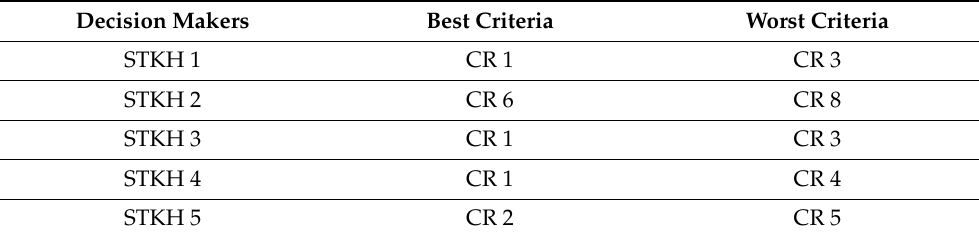
Table 6. Best and worst criteria selected by stakeholders.